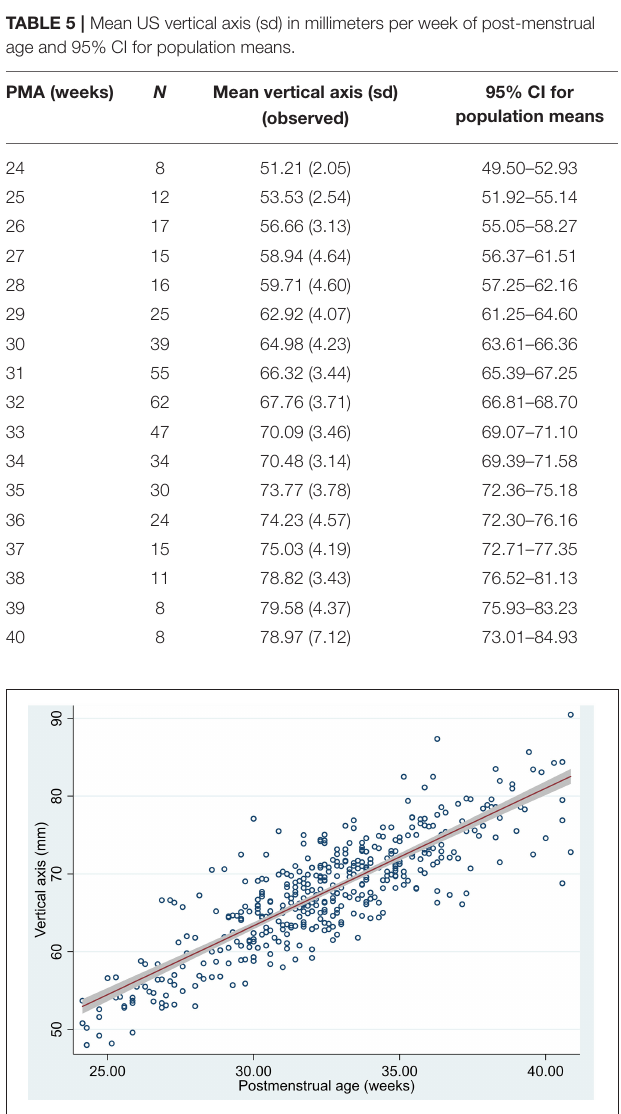
FIGURE 6 | Scatterplot of vertical axis by post-menstrual age measured in US, predicted mean and 95% confidence interval of the population means.